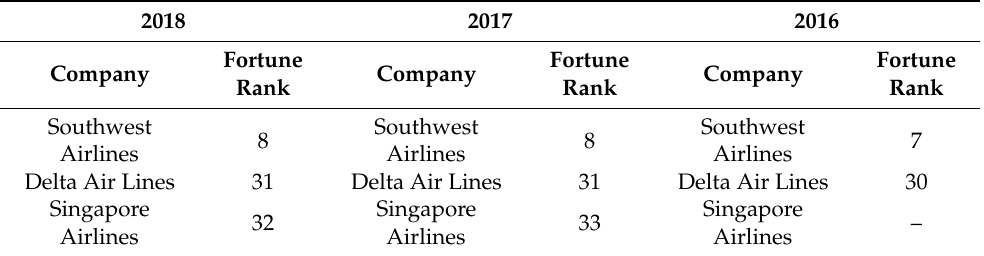
Table 2. The Fortune airline companies included in the ranking for their best company